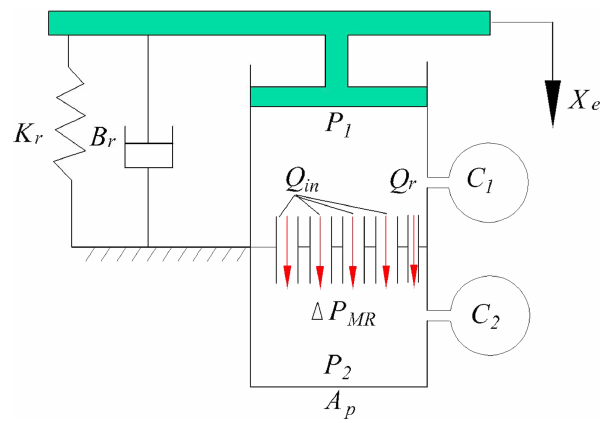
Figure 10. Multi-channel magnetorheological fluid mount of the lumped parameter